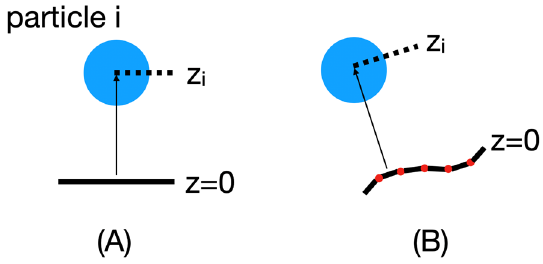
Figure 6. Schematic representation of particle position in the original planar implicit membrane frame ( A ) and in a mesh-based membrane of arbitrary shape ( B ). Particle i, represented by the blue circle, has position z i , which is used to evaluate the function C(z). Originally, z i is simply the z-coordinate of the particle minus the z-coordinate of the membrane centre. In a mesh-based implementation, z i becomes the distance of particle i from the membrane in the direction of the membrane normal.